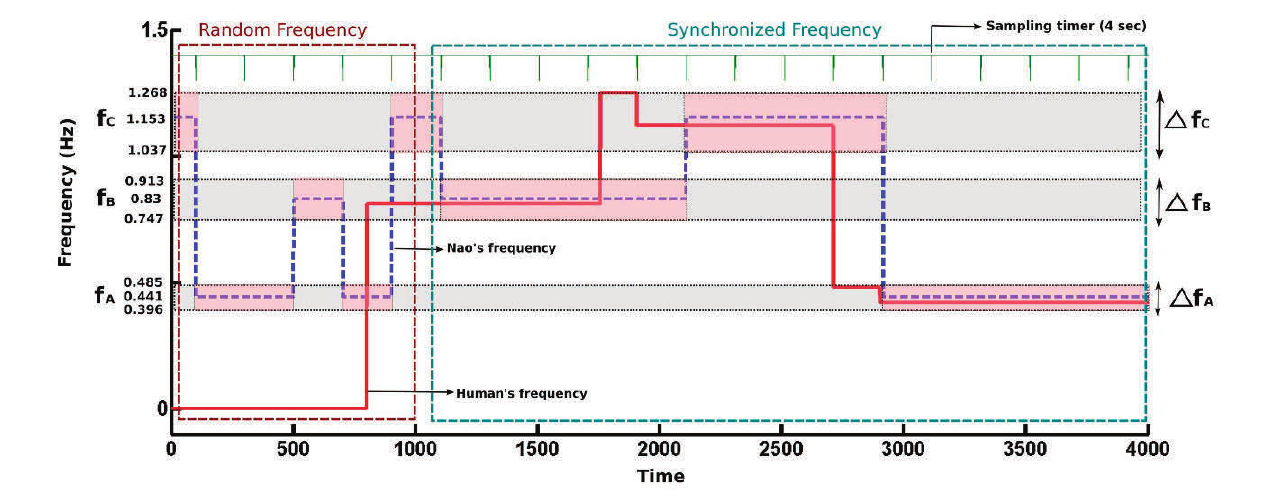
Figure 8. Shows how the di(cid:636)erent oscillators (A, B and C) are selected according to the visual stimuli. Due to the lack of interactant, random selection of the oscillators is observed. After 800 (26.6 sec) time units, oscillators are chosen according to the frequency of the agents. Nao’s oscillator selection (doted line) according to human frequency (solid line)